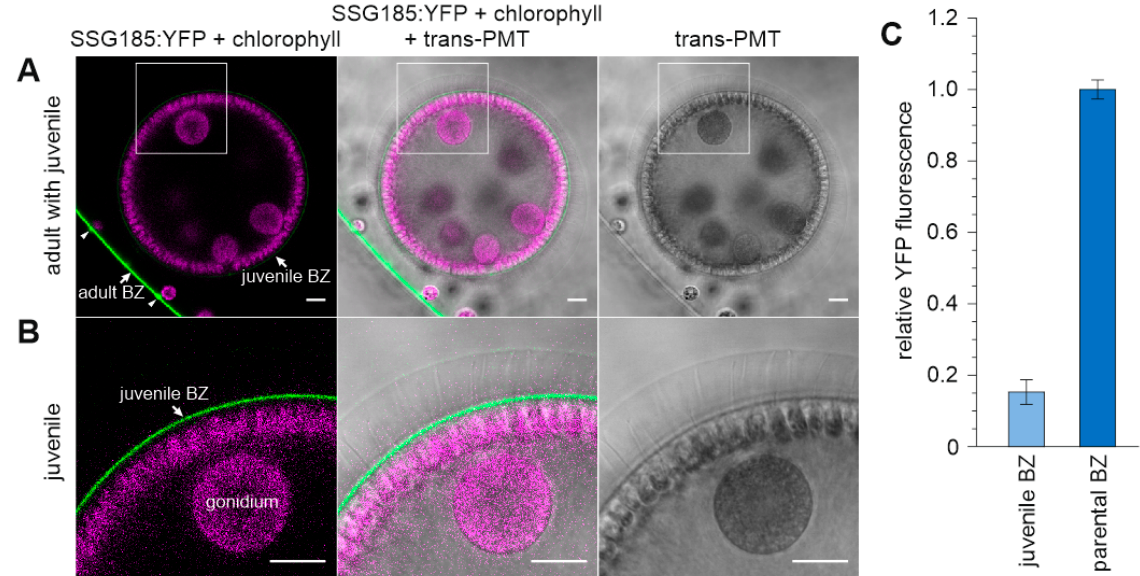
Figure 9. Beginning accumulation of SSG185:YFP at the surface of juveniles after embryonic inversion. Juveniles of transformants expressing the ssg185 : yfp gene were analyzed in vivo for the localization of the SSG185:YFP fusion protein. The juveniles are located inside their parental spheroid and their developmental stage is 1.5 h after embryonic inversion. The boundary zones (BZ) both of the adult and the juvenile are indicated. Transmission-PMT (trans-PMT) images are included for orientation. ( A ) CLSM optical cross-section showing a part of an adult with one of its juveniles inside. Note that the YFP signal intensity of SSG185:YFP is much stronger in the adult BZ than in the juvenile BZ. Furthermore, the YFP signal can be found at the flagellar hillocks of the adult (arrowheads) but not at those of the juvenile. The latter becomes clearer in B. ( B ) Magnified detail of the framed area in A. It should be emphasized that the YFP signal in B was amplified with higher gain than in A. Column 1: Overlay of YFP fluorescence of SSG185:YFP protein (green) and chlorophyll fluorescence (magenta). Column 2: Overlay of SSG185:YFP fluorescence (green), chlorophyll fluorescence (magenta) and transmission-PMT (trans-PMT). Column 3: Transmission-PMT alone. Scale bars: 10 μ m. ( C ) Comparison of the YFP fluorescence intensity in the BZ of juvenile algae 90 min after embryonic inversion with the parental BZ. Fluorescence intensity was quantified in the YFP channel (520–550 nm) in a straight line spanning through the corresponding BZ and the maximal value was recorded. The recorded intensity values were normalized to the highest recorded value in order to exclude the influence of differing laser intensities between the replicates. The data represent three biological replicates with three technical replicates each. Error bars indicate standard deviation of the mean of the three biological replicates.